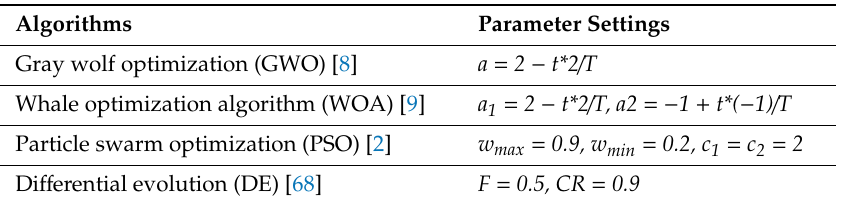
Table 4. The parameter settings for the other compared algorithms.